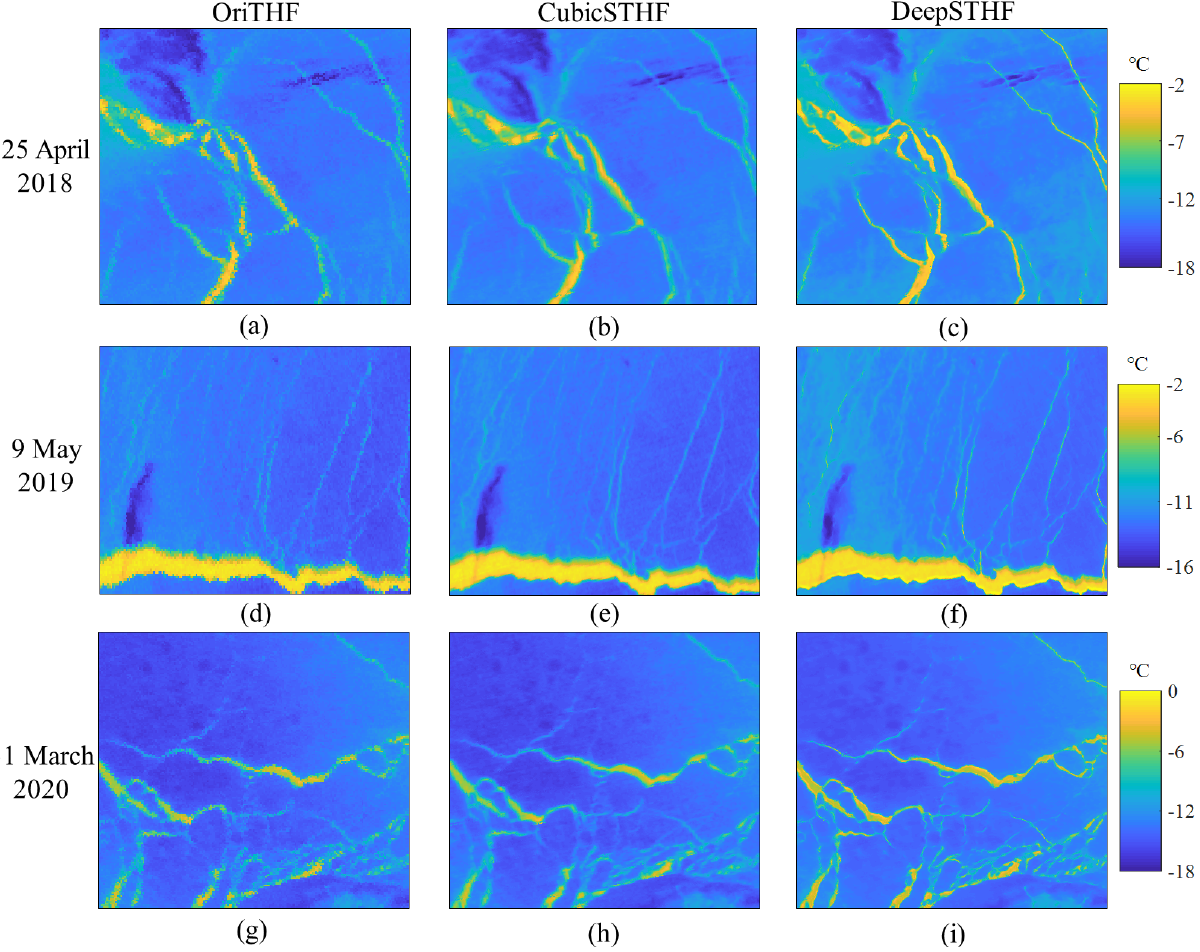
Figure 12. The IST images were acquired on (a–c) 25 April 2018, (d–f) 9 May 2019, and (g–f) 31 March 2020. The SR result was obtained by (a, d, g) the OriTHF method, (b, e, h) the CubicSTHF method, and (c, f, i) the proposed DeepSTHF